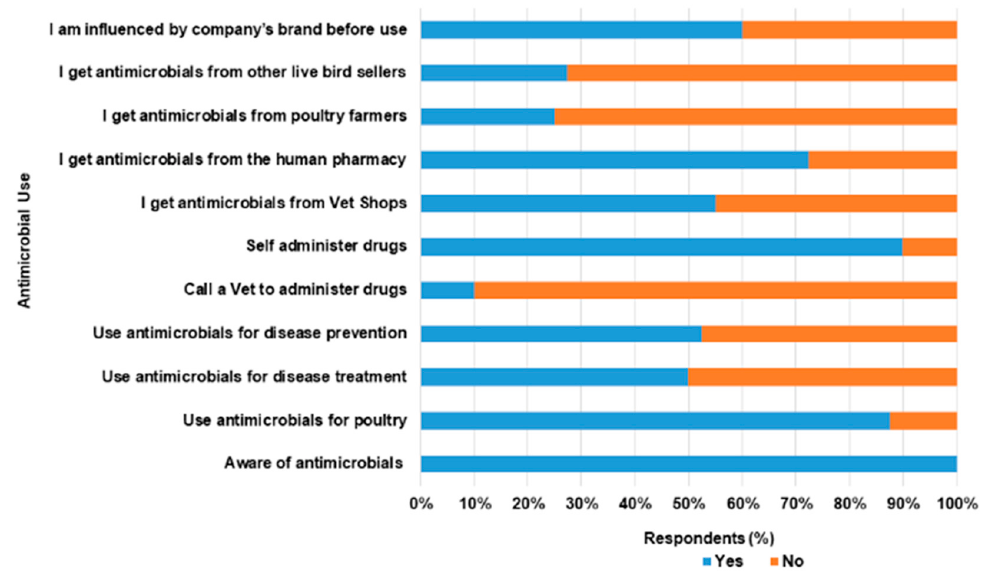
Figure 4. Antimicrobial use among live bird sellers in Abeokuta, Ogun State.